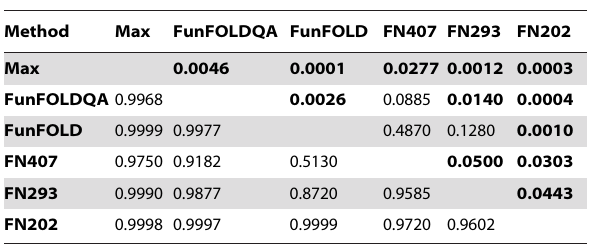
Table 4. All versus all analysis for the top methods in CASP8 along with the FunFOLD and FunFOLDQA methods.